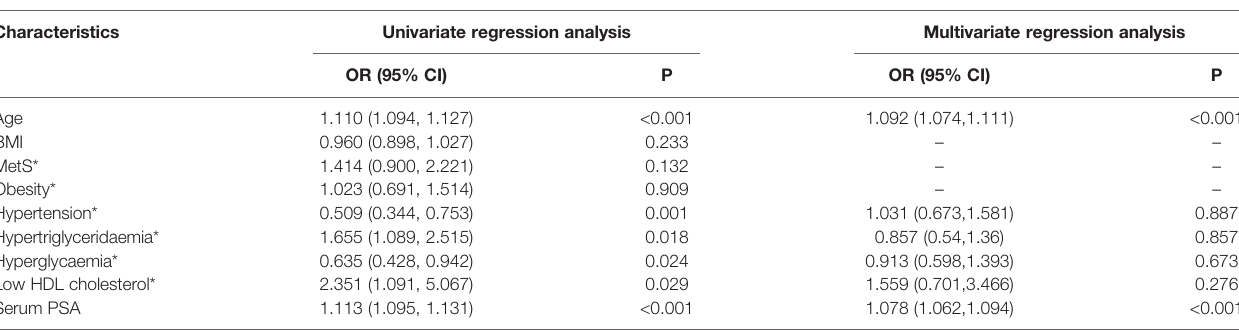
TABLE 2 | Analysis of risk factors of prostate cancer.